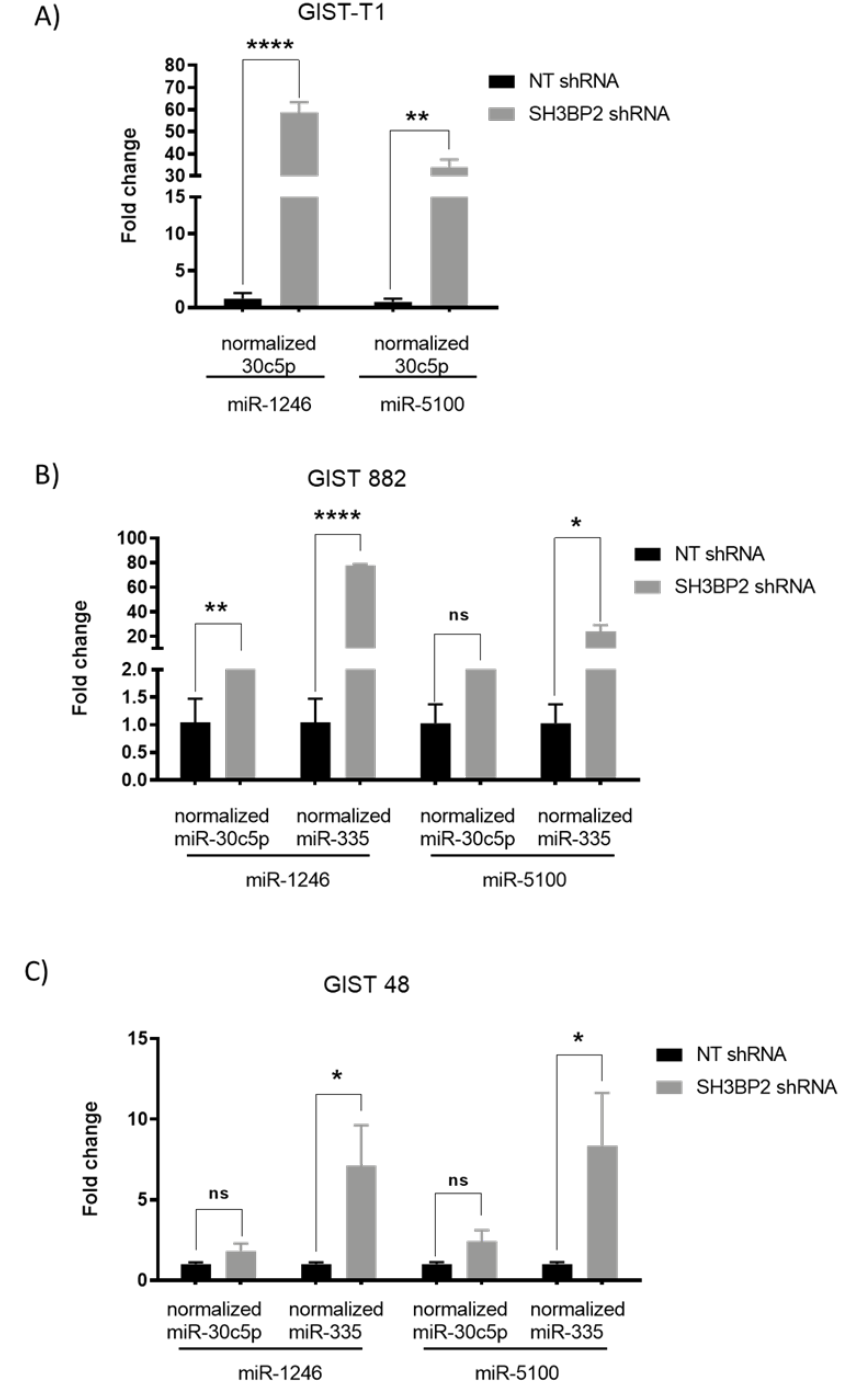
Figure 3. Validation of miRNA upregulation after SH3BP2 silencing by Real-Time PCR in GIST cell lines. GIST-T1, GIST882, and GIST48 cells were transduced with a non-target shRNA sequence or a specific shRNA SH3BP2. MiR-335 and miR-30c5p were used as housekeeping miRNAs. ( A ) GIST-T1 Data represent one biological replicate performed two times. ( B ) GIST 882 Data are representative of two biological replicates performed two times. ( C ) GIST 48 Data represent three biological replicates performed two times. (* p < 0.05, ** p < 0.01, **** p < 0.0001; Unpaired t -test; mean ± SEM).